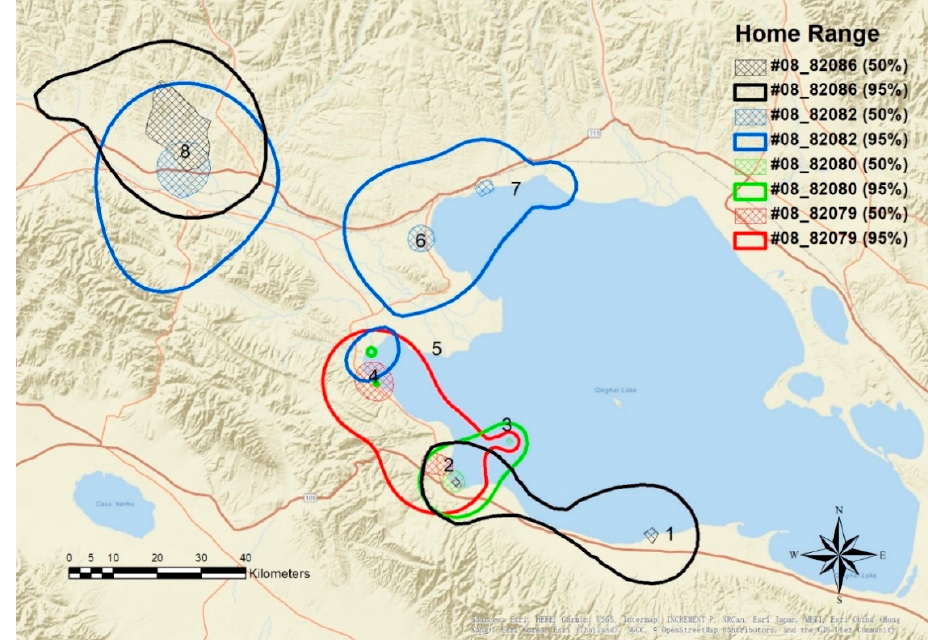
Figure 3. Home range (95% contour) and core area (50% contour) of four Bar-headed Geese ( Anser indicus ) captured in 2008 in Qinghai Lake (March-September) created using a Brownian Bridge Movement Model. Core areas and codes: 1. Jiangxigou, 2. Heimahe Estuary, 3. Sankuaishi Island, 4. Garila and Quanwan, 5. Shenhe Estuary, 6. Hadatan, 7. Quanjihe Estuary, and 8. Luonia.